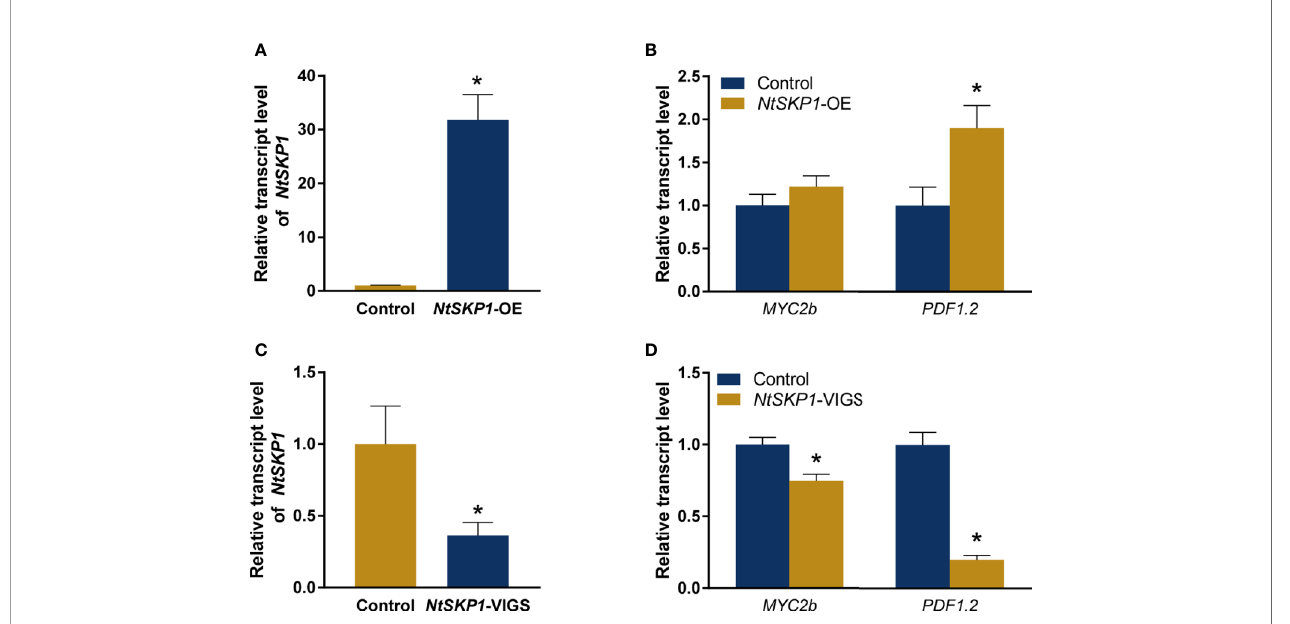
FIGURE 4 | NtSKP1 affects the transcription of genes in JA signaling pathway. (A) Relative transcript levels of NtSKP1 in control and NtSKP1 -overexpressed ( NtSKP1 -OE) tobacco plants. Values are mean ± SEM, n = 6. (B) Relative transcript levels of MYC2b and PDF1.2 in control tobaccos (Control) and NtSKP1 - overexpressed ( NtSKP1 -OE) tobaccos. Values are mean ± SEM, n = 6. (C) Relative transcript levels of NtSKP1 in control and NtSKP1 -silenced ( NtSKP1 -VIGS) tobacco plants. Values are mean ± SEM, n = 6. (D) Relative transcript levels of MYC2b and PDF1.2 in control tobaccos (Control) and NtSKP1 -silenced ( NtSKP1 - VIGS) tobaccos. Values are mean ± SEM, n = 6. Total RNAs were extracted from each plant respectively and subjected to qRT-PCR to quantify the mRNA levels of target genes. GAPDH was used as the internal reference. Student ’ s t test was used for signi fi cant difference analysis (* P < 0.05).